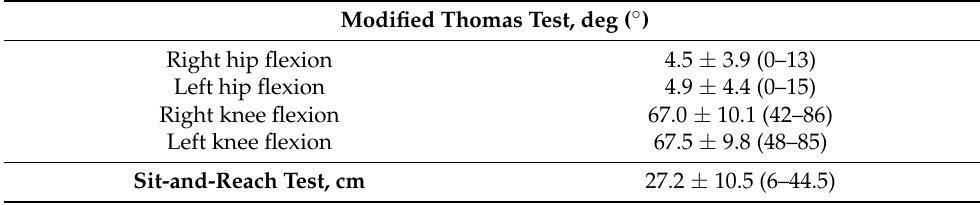
Table 4. Data on flexibility tests a